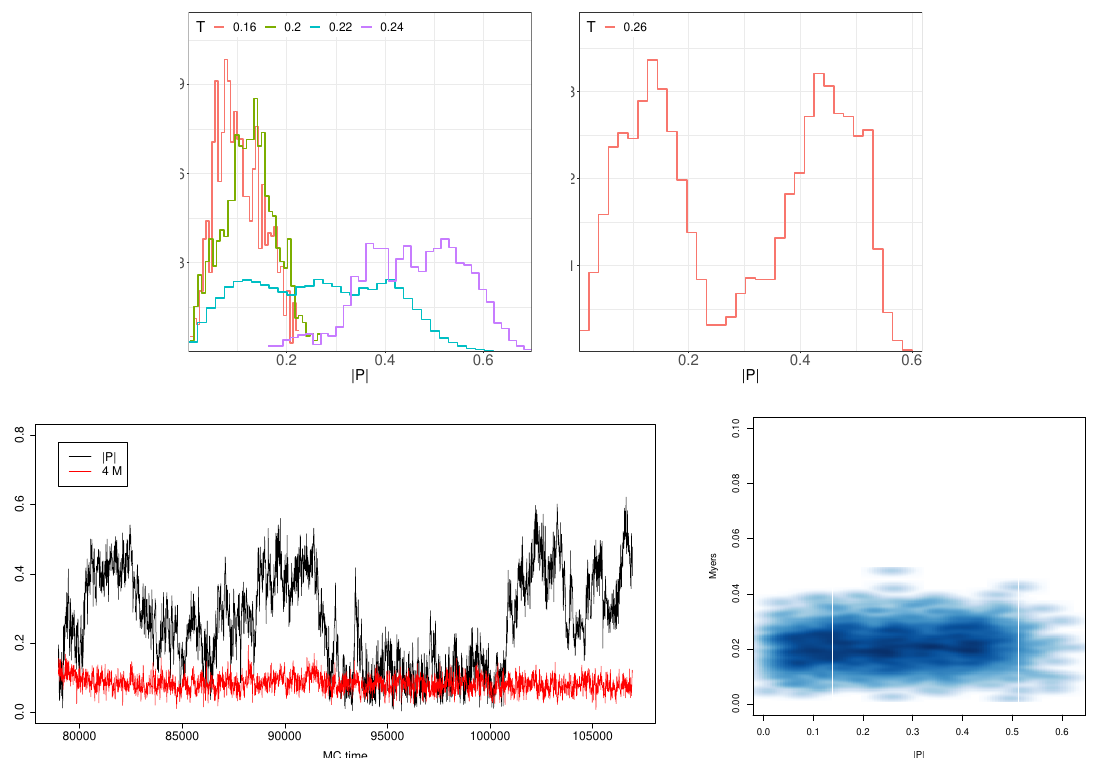
Figure 24. Full BMN, the histograms of the Polyakov distribution, and relative Monte Carlo histories for small µ . [Top-Left] N = 12 , L = 24 at µ = 0 . 3 . A possible two-state signal is observed. At T = 0 . 24 we observe runaway behavior of R 2 , as well as in the deconfined sector at T = 0 . 22 . [Top-Right] N = 16 , L = 24 at µ = 0 . 5 . For µ = 0 . 5 , the histogram was obtained by adding